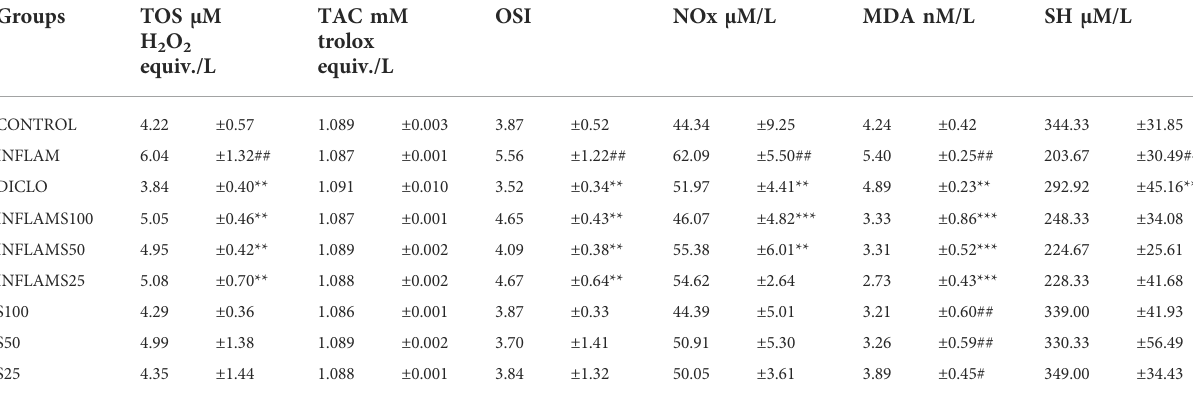
TABLE 4 Determined parameters used in the evaluation of the in vivo anti-in fl ammatory effects of Salvia glutinosa extracts.